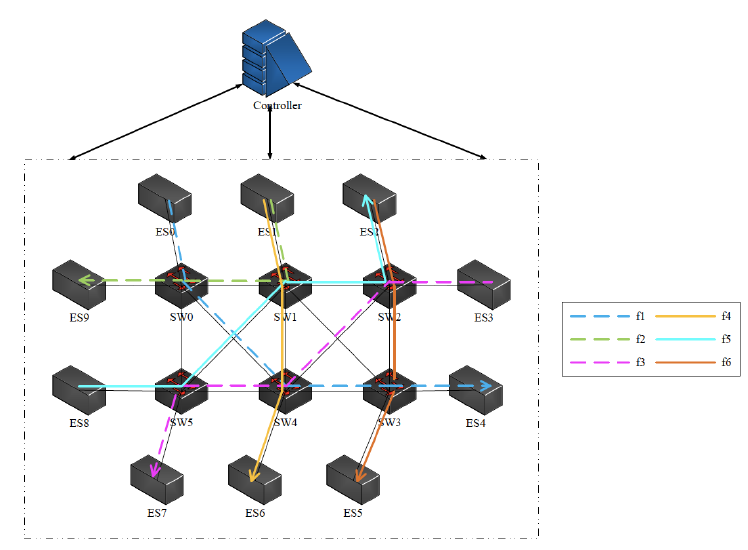
Figure 1. Example TSN topology model G ( 16,21 ) including ten end systems which schedule six types of flows via six switches with multiple no-conflict paths. A controller collects application information and network topology information and reports to scheduler module. The schedule results can be deployed on the TSN